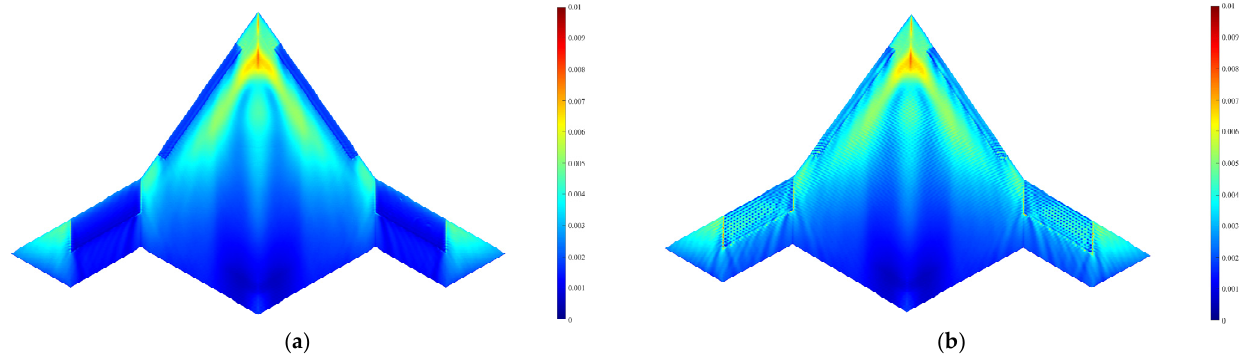
Figure 15. Current distribution of the UVA ( a ) with honeycomb RAS and ( b ) without honeycomb RAS. Table 1. Computational statistics of the UVA scale models.